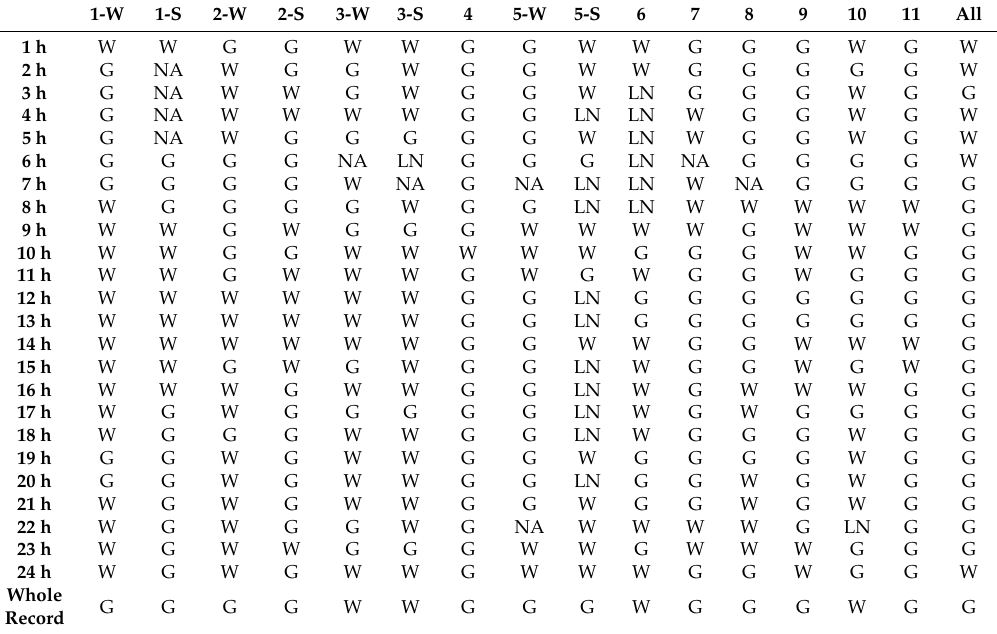
Table A2. Best fitted distributions at the nonzero hourly demand records per household and per hour according to the ER 1 measure. “W” stands for Weibull distribution, “G” for Gamma distribution, and “LN” Lognormal distribution while “NA” was used in records where it was not possible to fit the models.